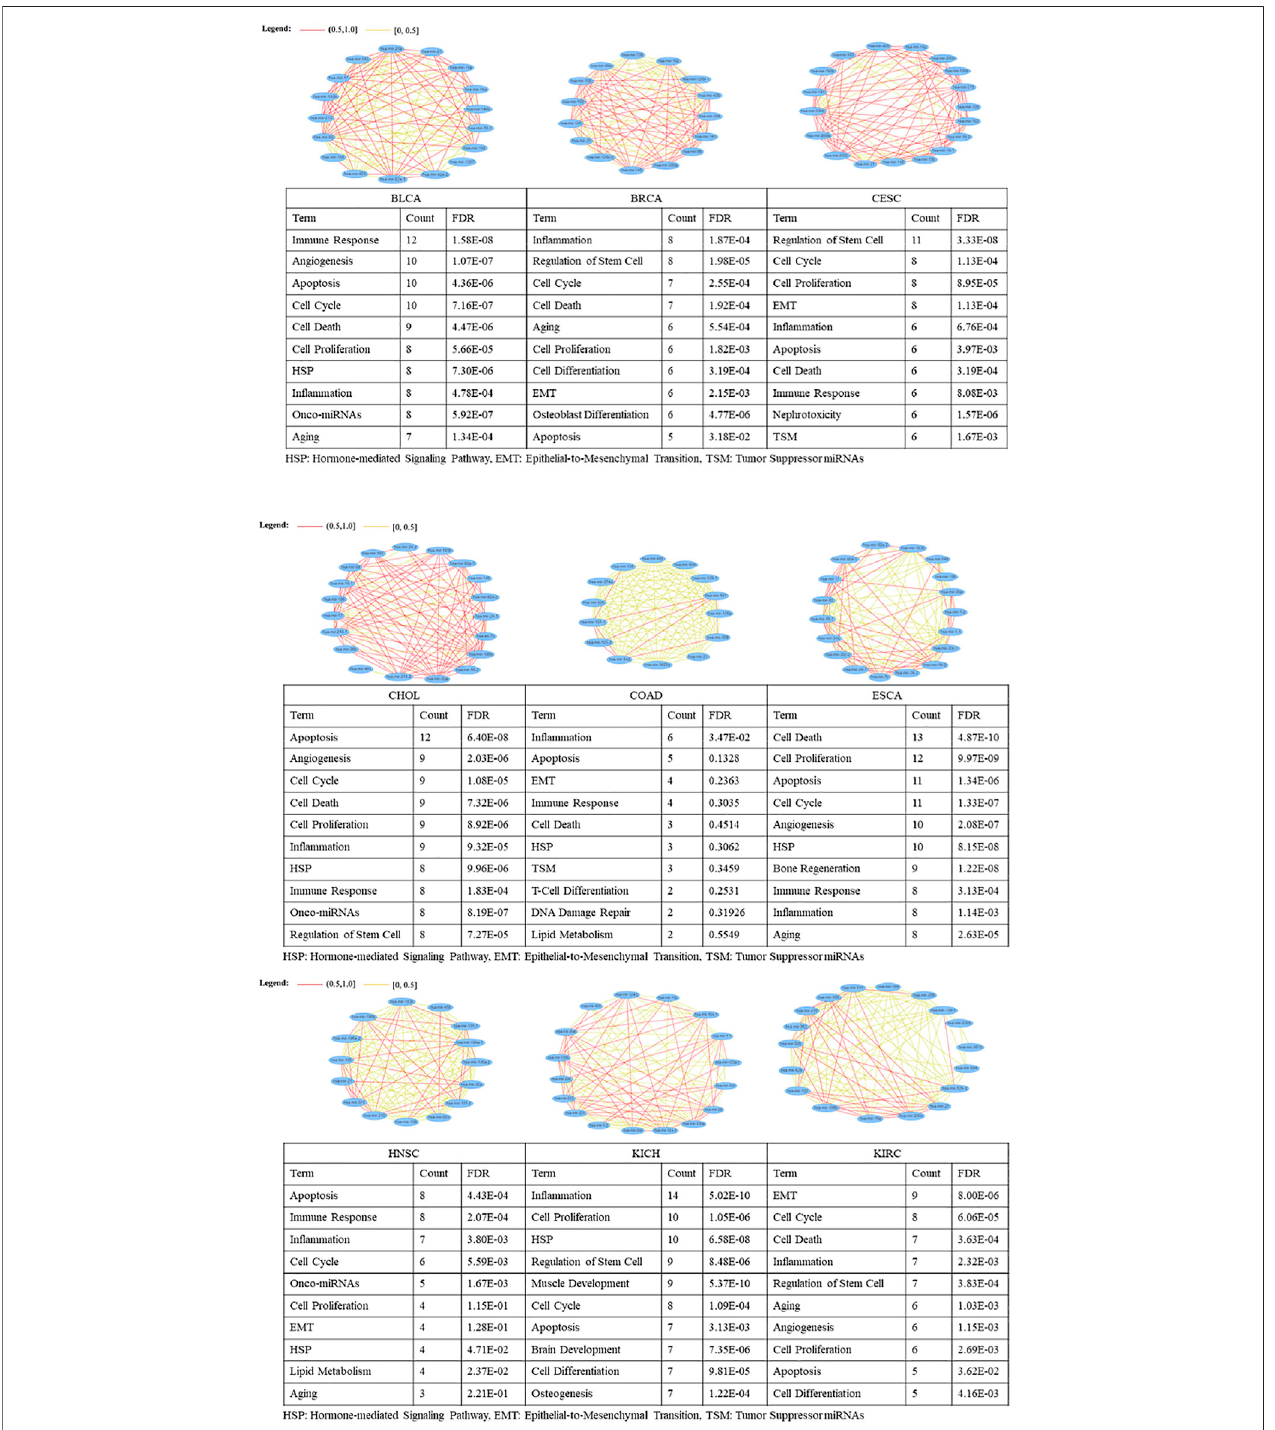
FIGURE 5 | Biological function similarity analysis of the top-20 ranked miRNAs.